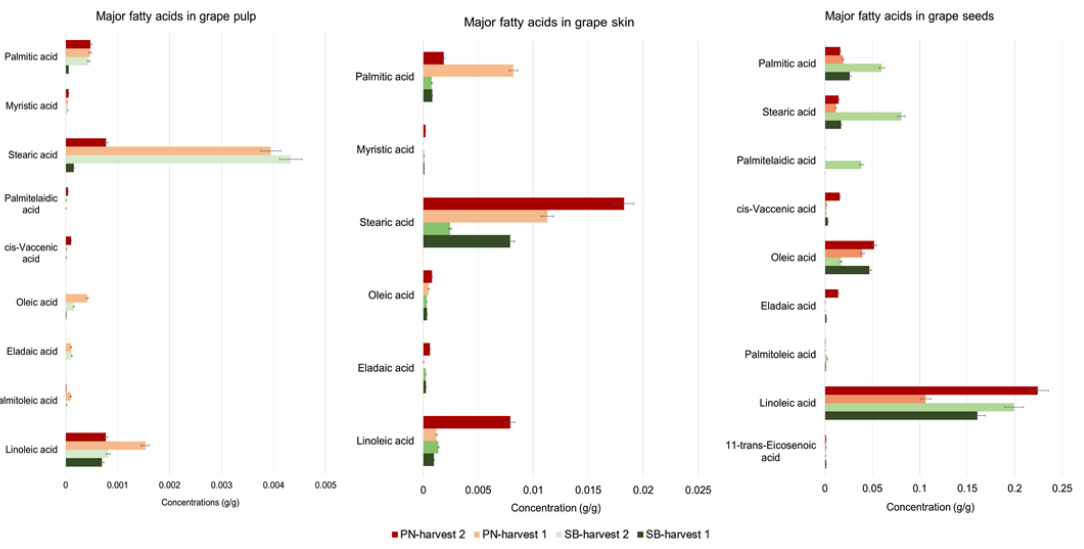
Figure 2. Concentrations of major fatty acids in Pinot noir (PN) and Sauvignon blanc (SB) grape pulp, seed and skin. Fatty acid profiling was completed using 10 mg of each sample type.